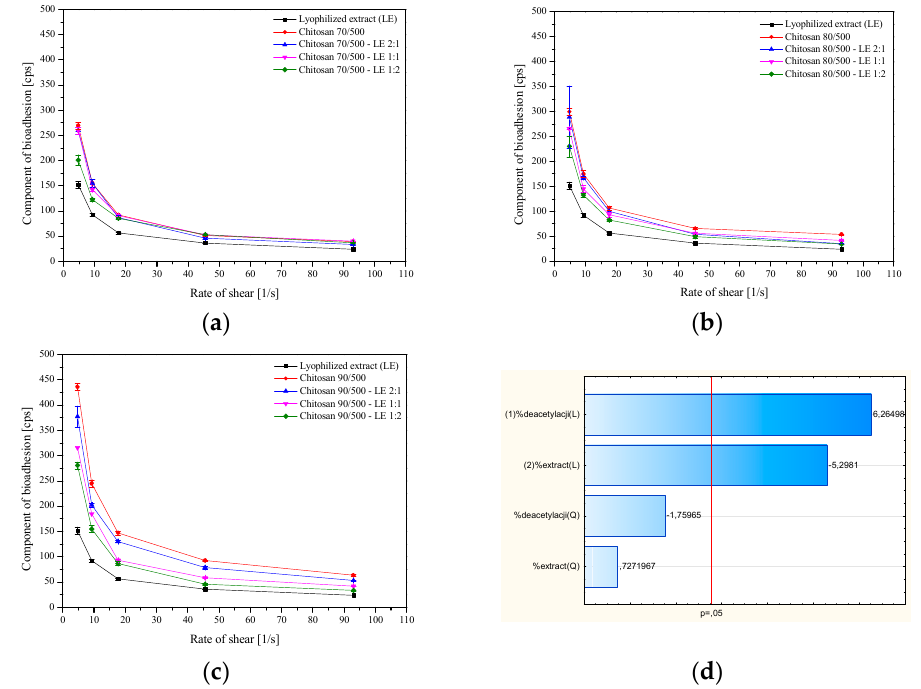
Figure 8. Component of bioadhesion of systems with chitosan 70/500 ( a ), chitosan 80/500 ( b ), and chitosan 90/500 ( c ), and Pareto plot of standardized effects for the component of bioadhesion ( d ).